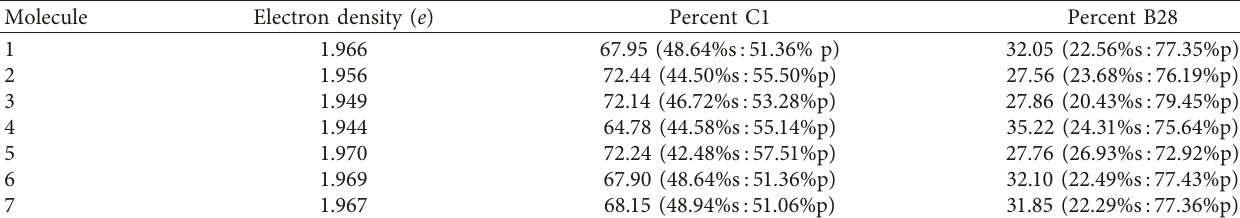
Table 5: Percent distribution of electrons in the C1-B28 bond with the corresponding s and p characters.